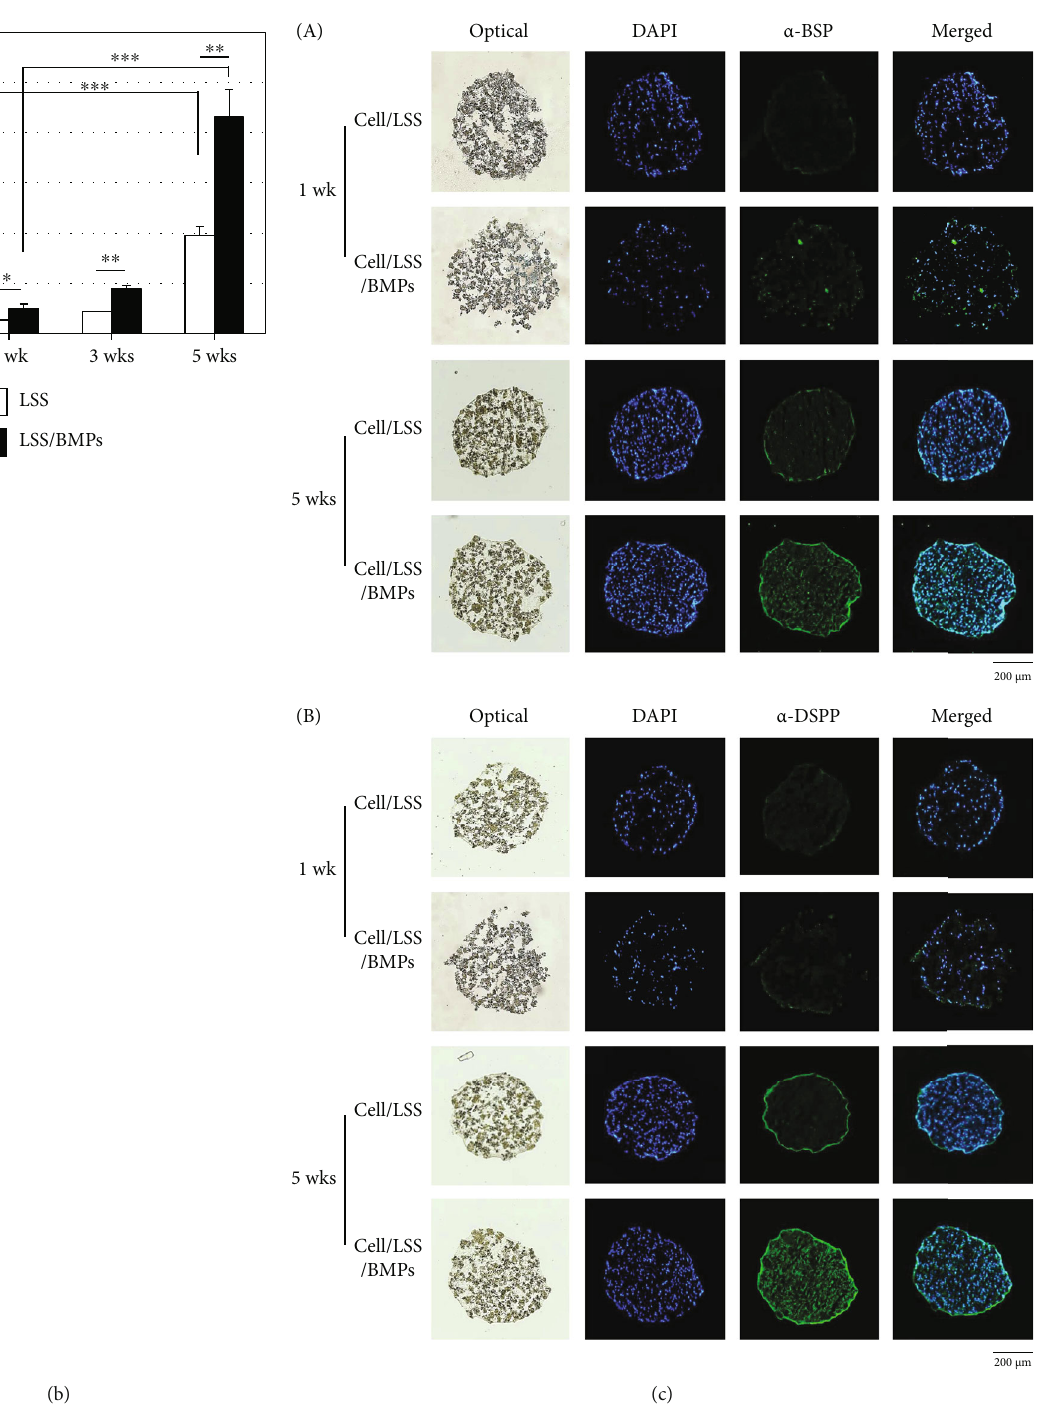
Figure 3: Odonto/osteoblastic di ff erentiation of 3D spheroid-cultured hDPSCs improves by the sustainably released BMP-2 and BMP-4. (a) Odonto/osteoblastic marker gene expression of hDPSC spheroids. (A) Osterix. (B) Dentin matrix protein-1. (C) Osteocalcin. (D) Bone sialoprotein. (E) Collagen type-1. ∗ P < 0 : 05 ; ∗∗ P < 0 : 01 ; ∗∗∗ P < 0 : 001 ; NS: not signi fi cant. (b) Calcium deposition in spheroids. 30 spheroids were collected to analyze the amounts of calcium as followed in Experimental procedures. White bars, cell numbers in spheroids containing particles without BMPs; black bars, cell numbers in spheroids containing particles loaded BMPs. ∗ P < 0 : 05 ; ∗∗ P < 0 : 01 ; ∗∗∗ P < 0 : 001 . (c) Immunohistochemical staining of hDPSCs spheroids for two representative odontoblastic markers such as bone sialoprotein (A) and dentin sialophosphoprotein (B). The para ffi n section of hDPSC-spheroids collected at an indicated time was treated with the primary antibody, followed by FTIC-conjugated secondary antibody. LSS: spheroids containing particles without BMPs; LSS/BMPs: spheroids containing particles loaded